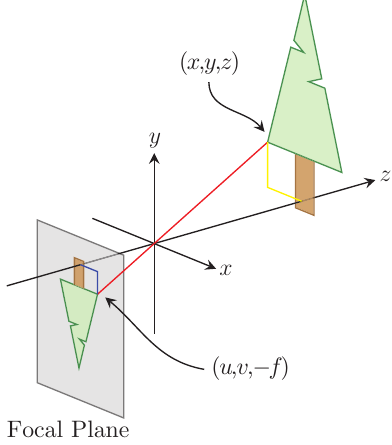
Figure 3. The classic pinhole model of a camera.